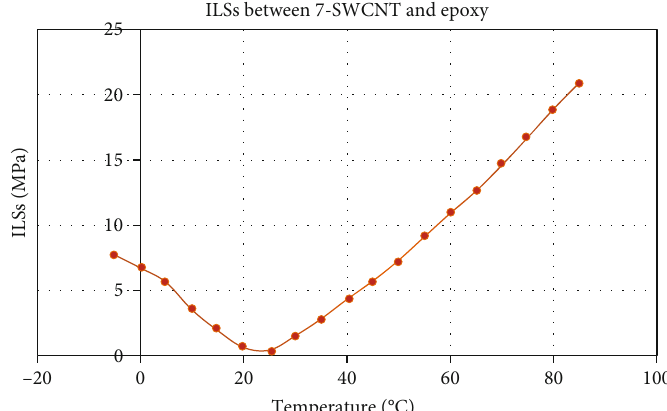
Figure 8: ILSs within the interface between the 7-SWCNT and epoxy at the temperature range of -5 to 85 ° C within the 7-SWCNTE.